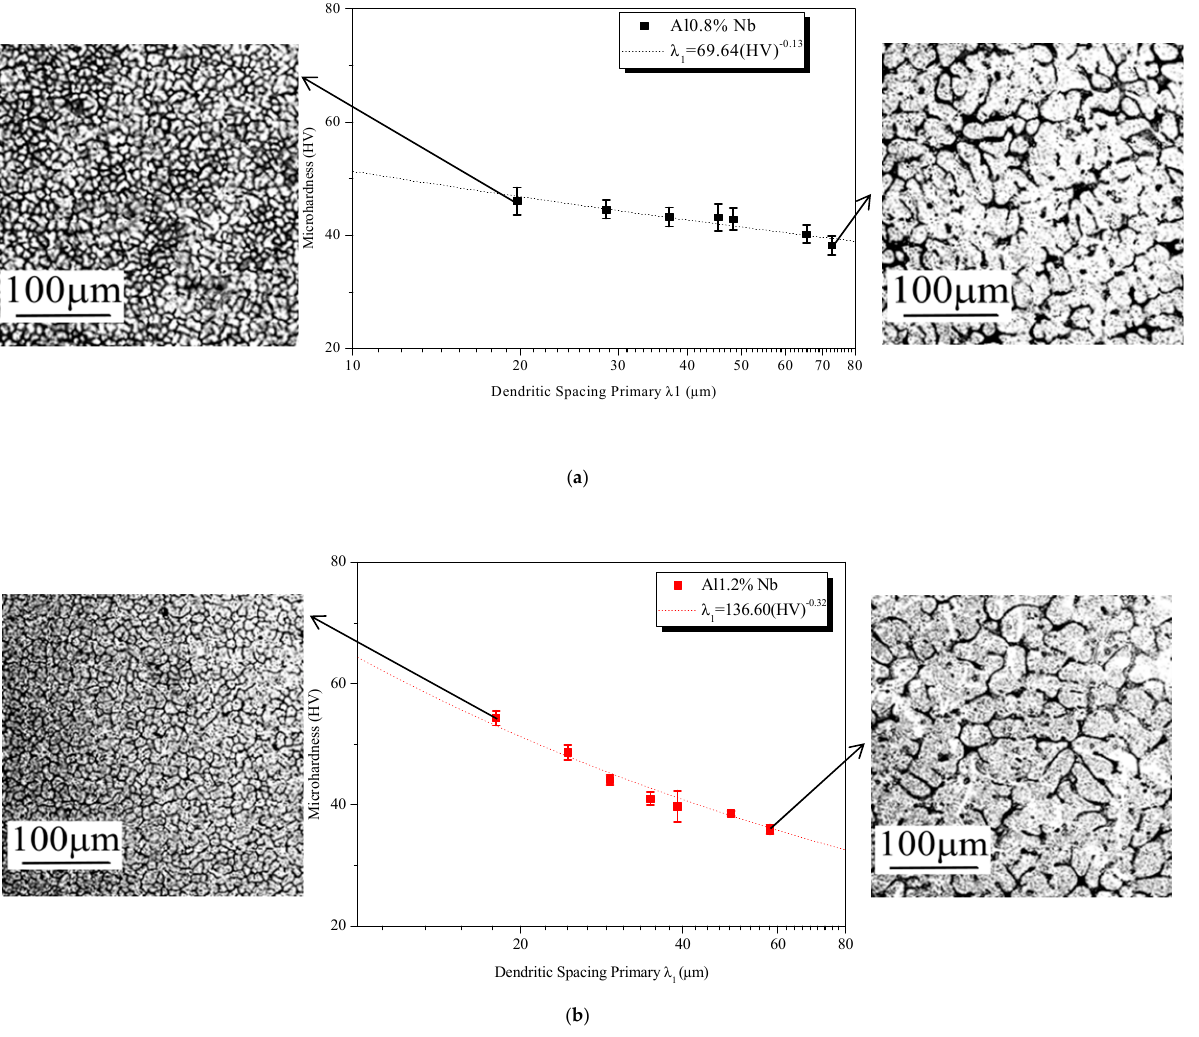
Figure 14. Microhardness as a function of the primary dendritic spacing. ( a ) Al–0.8 Nb and ( b ) Al–1.2 Nb (wt.%).